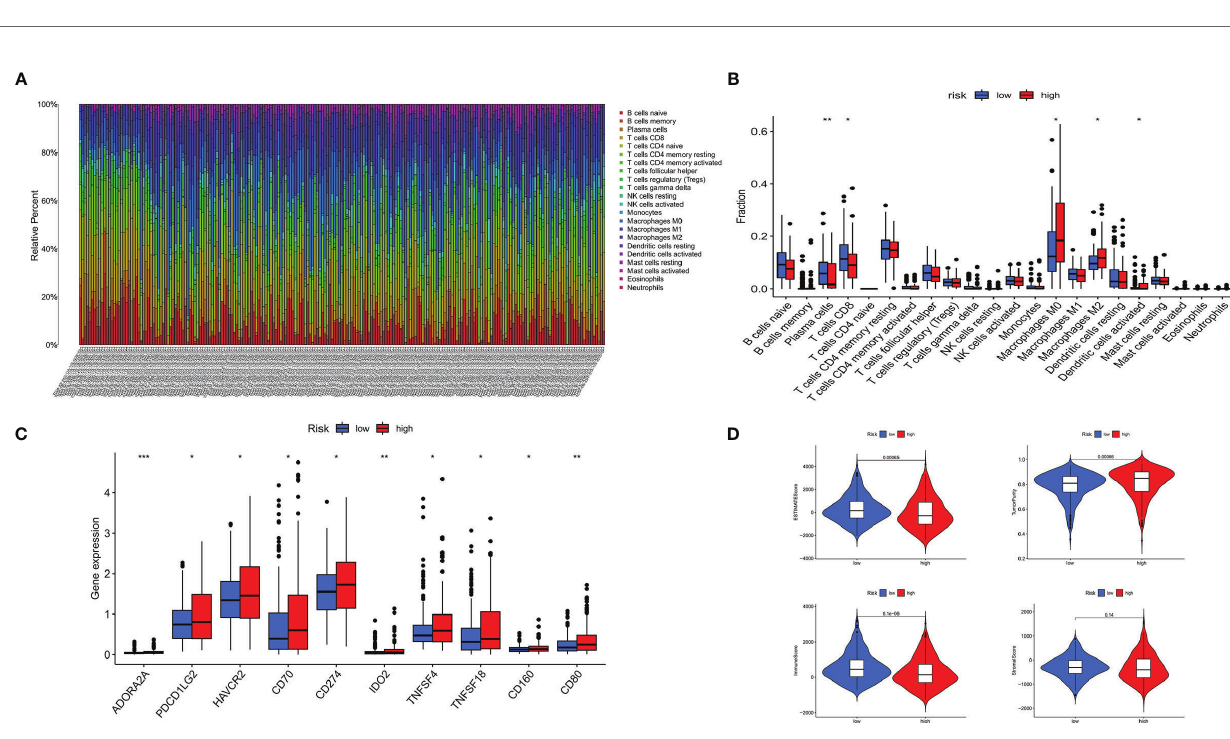
FIGURE 7 | Immune landscape of patients with THCA. (A) Proportion of 22 types of immune cells in 495 samples. (B) twenty-two types of in fi ltrating immune cells between the high- and low-risk groups in THCA. (C) Immune score between the high- and the low-risk groups in THCA. (D) Immune checkpoints between the high- and low-risk groups in THCA. * p < 0.05, ** p < 0.01, *** p <